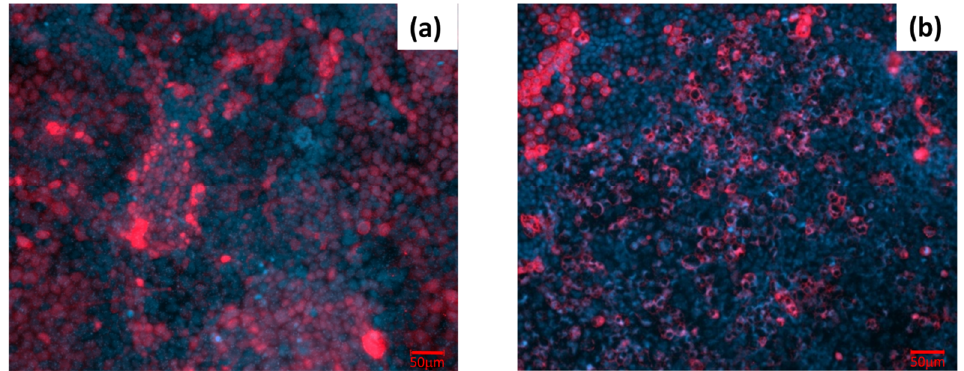
Figure 7. Fluorescent microscopy images of Caco-2 epithelial cell layer. Caco-2 monolayer, 21 days after seeding, before ( a ) and 2 h after ( b ) EGTA exposure. Cells were stained for E-cadherin (anti-E- cadherin Alexa Fluor 647, red) and nuclei (DAPI, blue).